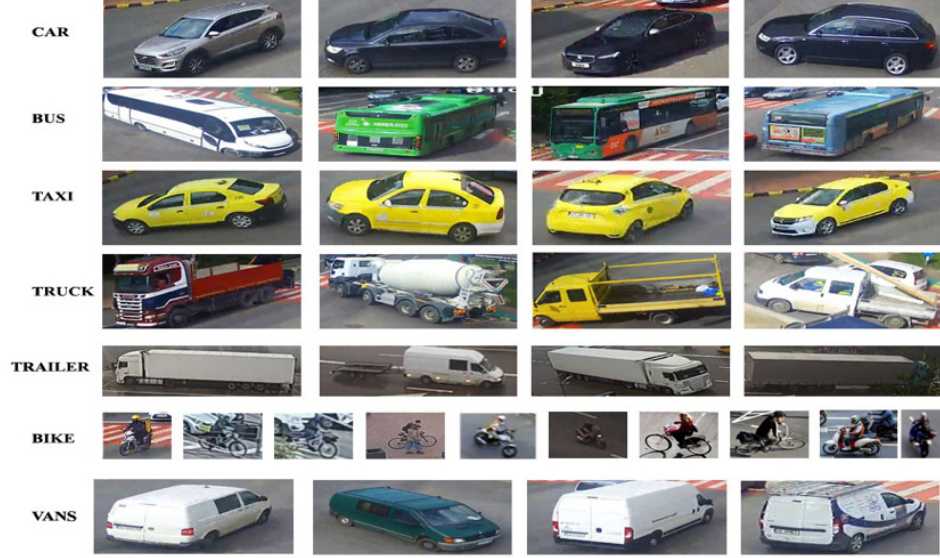
Figure 5. Sampling for vehicles, buses, taxis, bicycles, trucks, vans, auto-trucks.